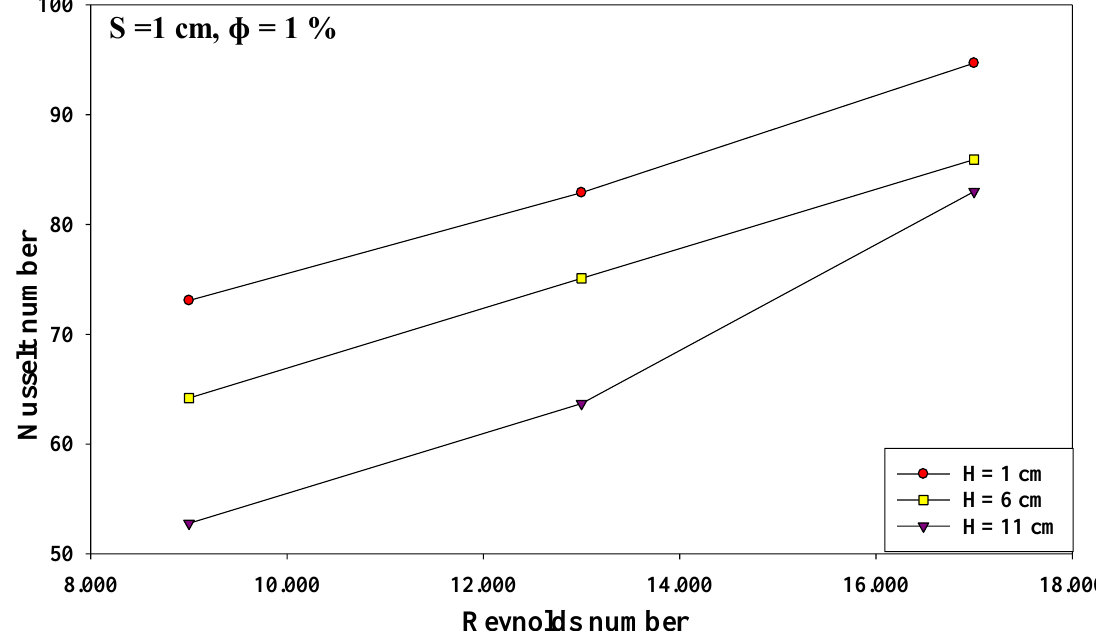
Figure 7. Effect of the Reynolds number and nozzle – plate distance when the nozzle – nozzle distance was 1 cm and other factors were maintained at their optimal levels.